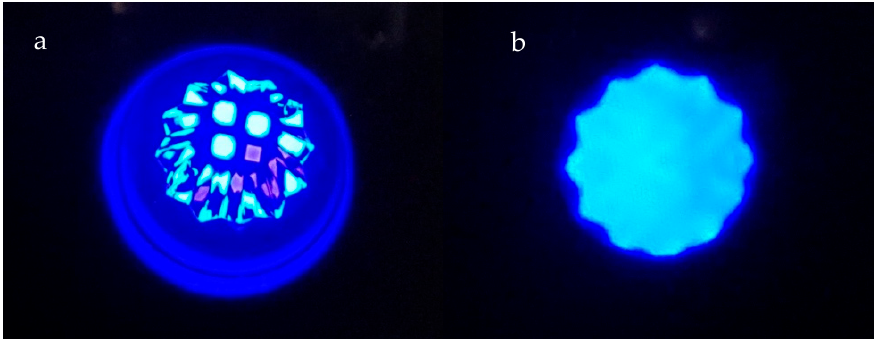
Figure 2. ( a ) Position of blue and violet light ‐ emitting diodes in the Bluephase PowerCure, sur ‐ rounded by the mirrors for detecting the backlight for determination of the proximity of the tooth structure; ( b ) light output at the tip of the light guide.